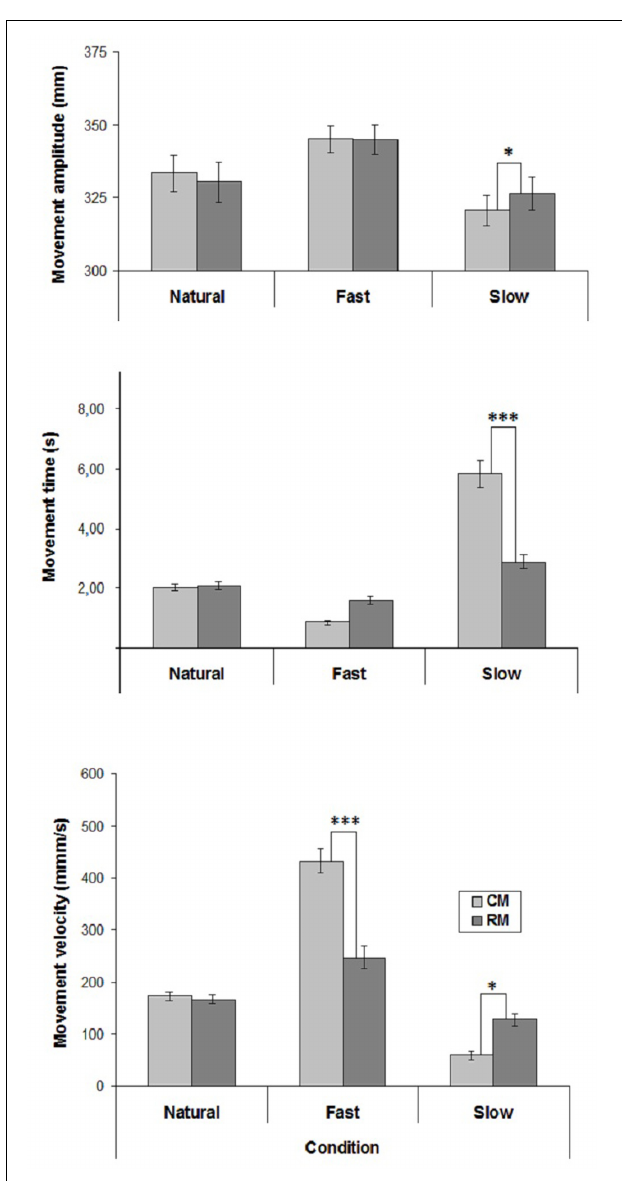
FIGURE 1 | Mean values of movement amplitude, time and mean velocity in the three experimental conditions of Experiment 1. Mean values are shown with SE ( bars ). CM, criterion movement; RM, reproduction movement. ∗ p < 0.01, ∗∗ p < 0.001, ∗∗∗ p <